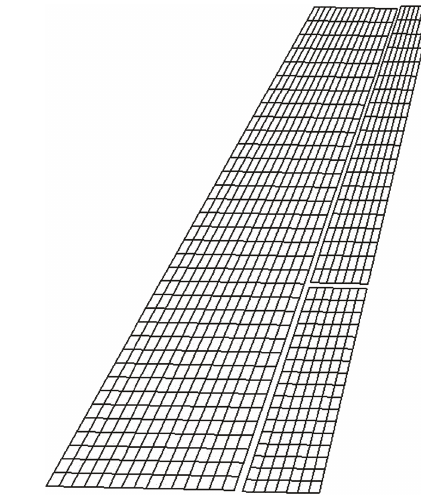
Figure 10: Aerodynamic meshes of the wing.